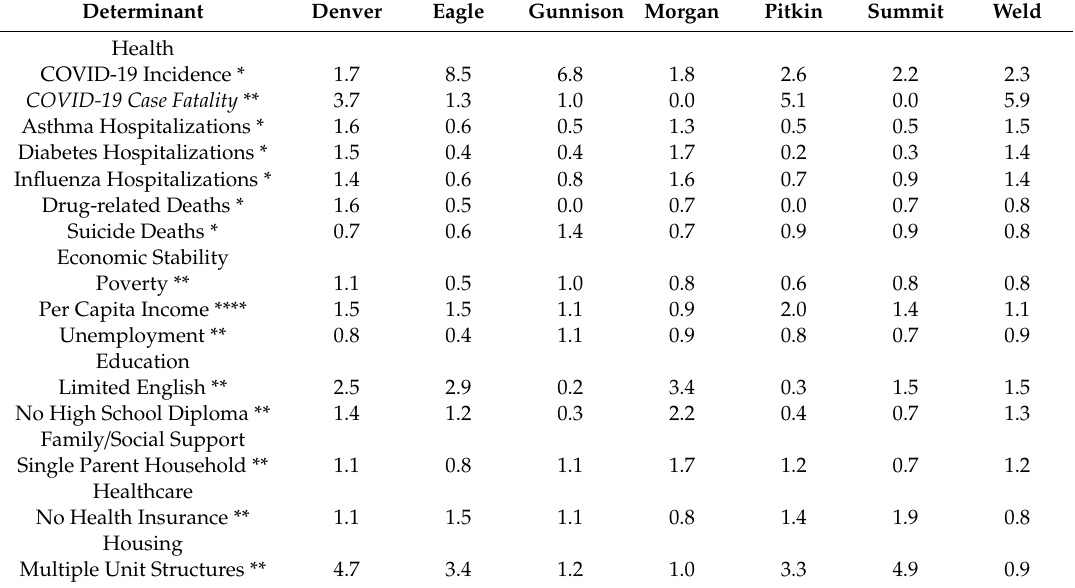
Profiles of social and health determinants in seven high COVID-19 incidence rate Colorado